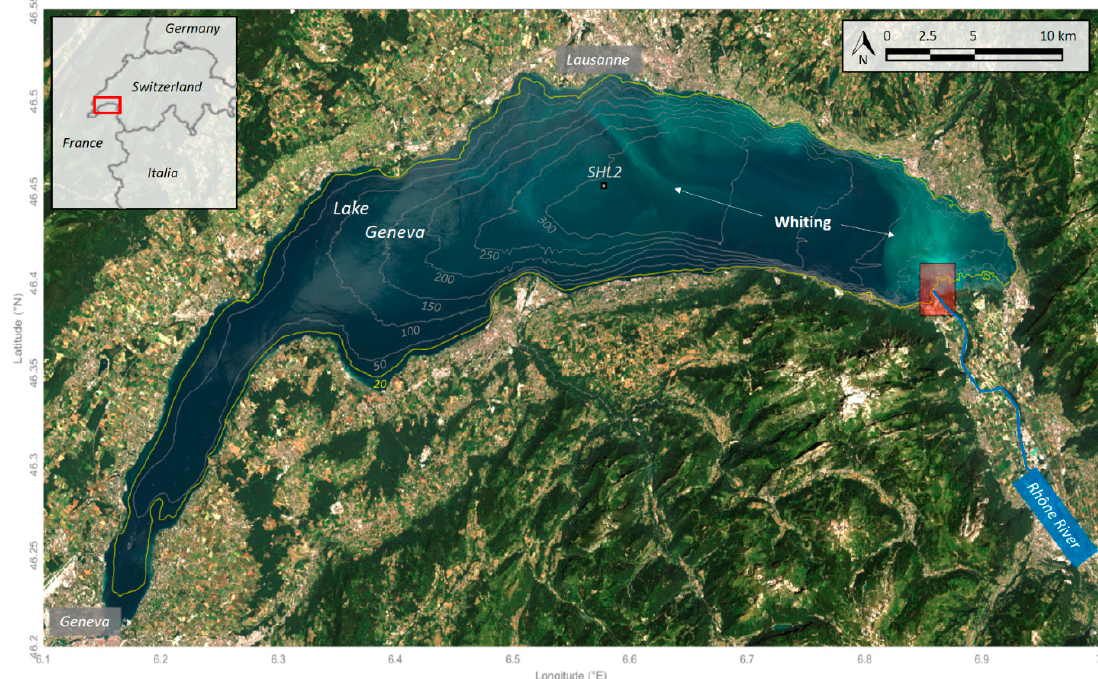
Figure 1. Map of the study area. RGB image from Landsat-8 of Lake Geneva on 29 June 2019. The whiting areas (i.e., turquoise ‘milky’ color of surface waters) are specified. The SHL2 monitoring point is shown in grey in the middle of the lake. The Rhone River is shown in blue. The lake’s location between France and Switzerland is shown in the top-left corner. The 20 m isobath is shown in yellow and the Rhone estuary area in red.